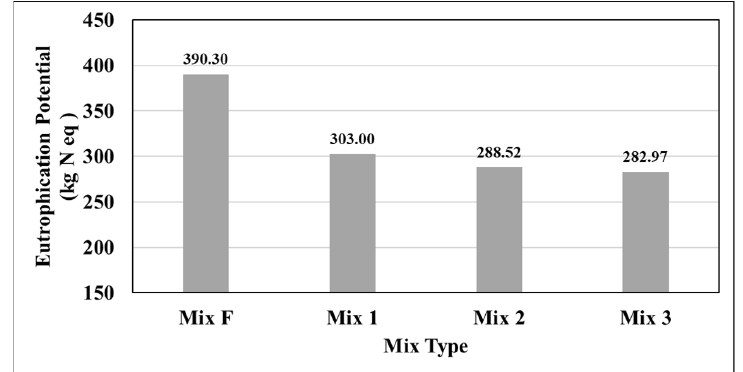
Figure 10. Eutrophication Potential (EP) by mix type.